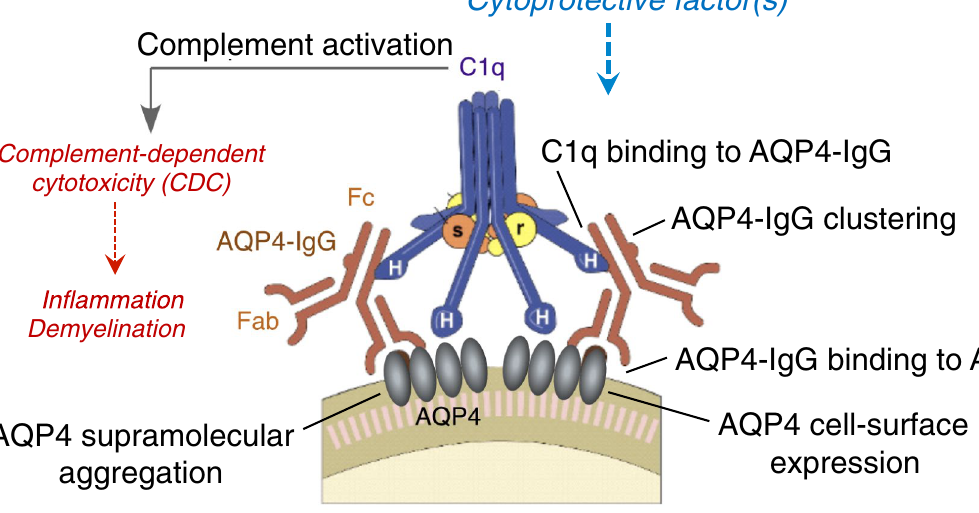
Figure 7. Potential mechanisms of cytoprotective IgG antibodies. Potential sites of action of cytoprotective IgGs include interference with complement activity, AQP4-IgG binding to cell-surface AQP4, supramolecular clustering of AQP4 or AQP4-IgG, and AQP4 cell-surface